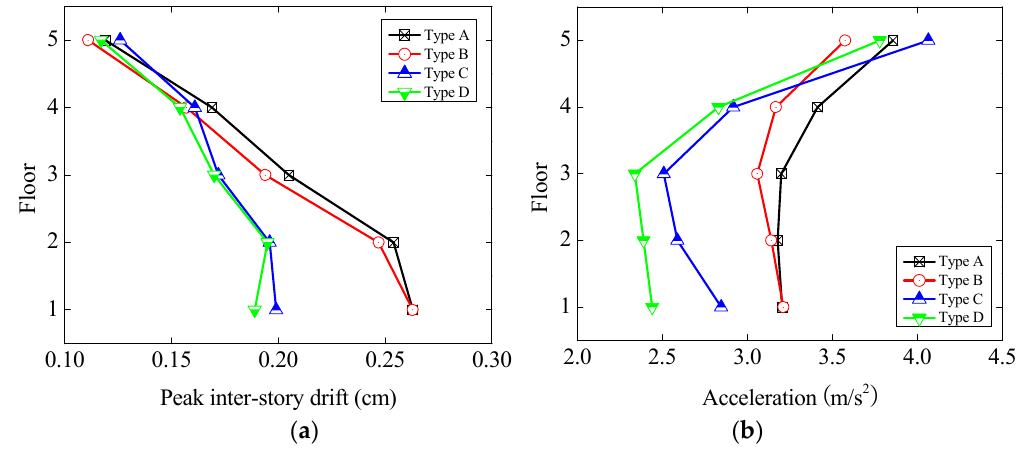
Figure 8. Average peak inter ‐ story drift and floor acceleration of controlled base ‐ isolated structure subjected to earthquakes: ( a ) average peak inter ‐ story drift; and ( b ) average peak floor acceleration.